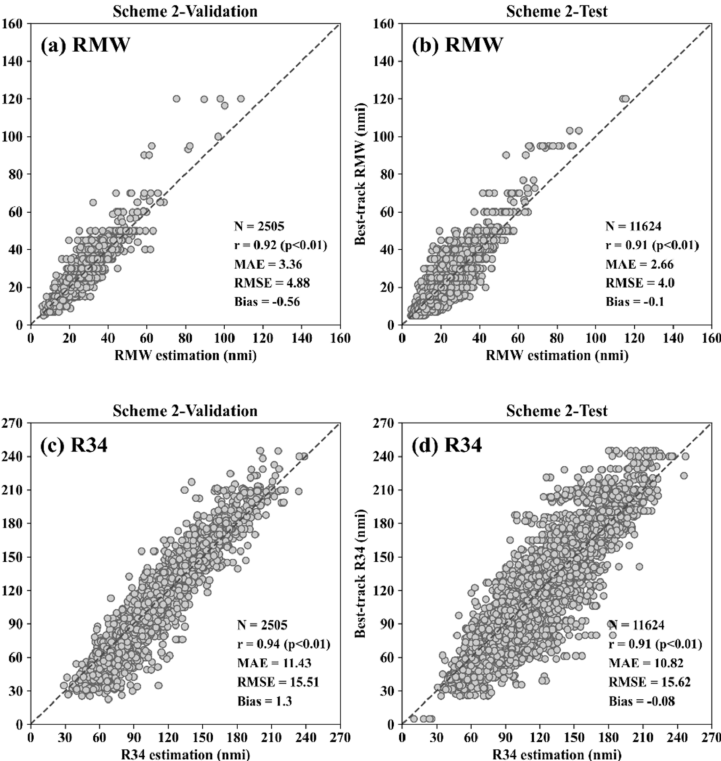
Figure 6. The same as Figure 5, but these were estimated using the multi-task model (Scheme 2). TC intensity was added to the multi-task model because it was expected that, since the intensity of a TC is generally related to its size, this information would improve the model’s performance. A significant negative correlation was found between TC intensity and the RMW (r = − 0.67, p < 0.01), with the RMW tending to decrease as TC intensity increased (Figure 7a). There was also a statistically significant correlation between R34 and TC intensity (r = 0.44, p < 0.01; Figure 7b). As shown in Figure 8, the inclusion of TC intensity information in the multi-task model further improved the accuracy of the RMW and R34 estimations in the validation (r = 0.97 and 0.95, MAE = 2.27 and 9.65 nmi, respectively; Figure 8a,c). Accordingly, the test results of the RMW and R34 estimations using Scheme 3 (r = 0.95 and 0.93, respectively; MAE = 2.05 and 9.77 nmi,